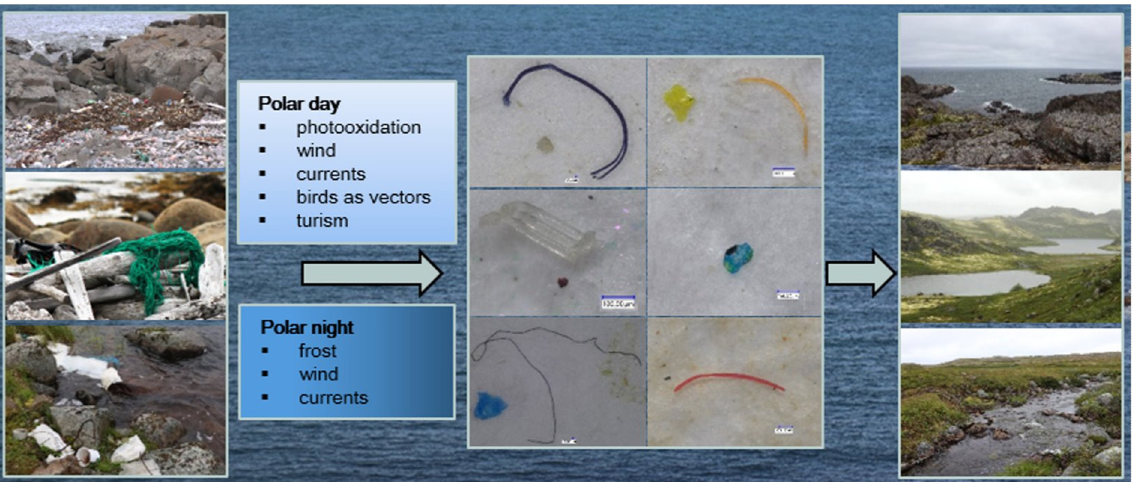
Figure 8. Photographic diagram depicting the main possible ways of fragmentation of plastic (textiles, fishing nets, ropes, pipes, single use packaging , bottles, containers) found in the seashore and tundra and the processes responsible for transport of microplastics (fragments and fibers) to aquatic environments in the Kola Peninsula region north of the Arctic Circle.